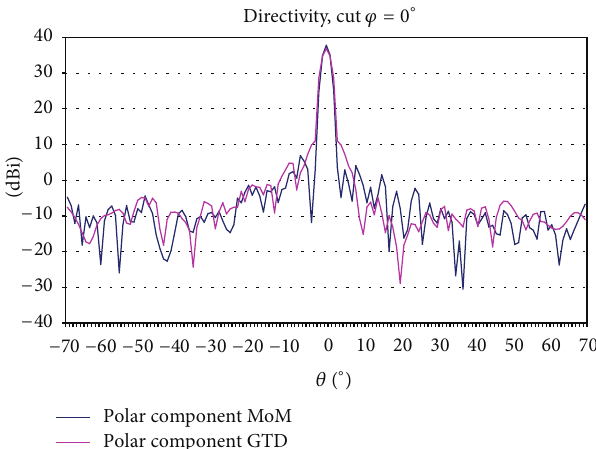
Figure 18: Polar component obtained with MoM and GTD, cut in 𝜑 = 0 ∘ .